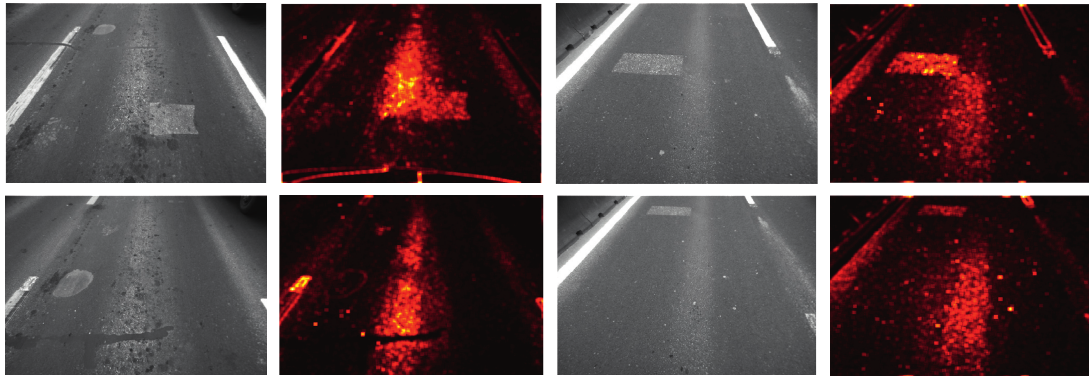
Figure 10: The key region extracted using